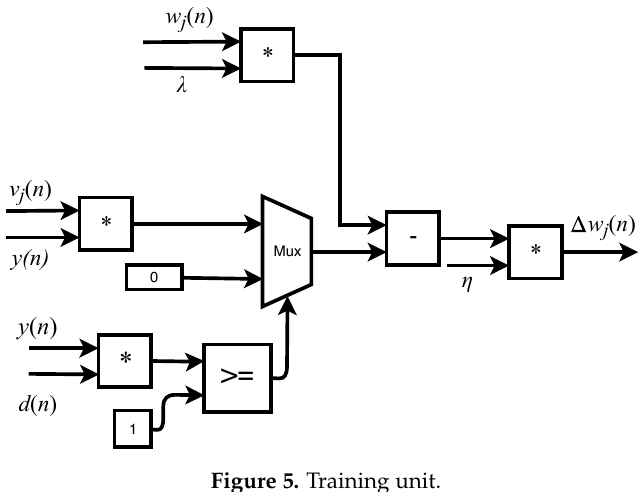
Figure 5. Training